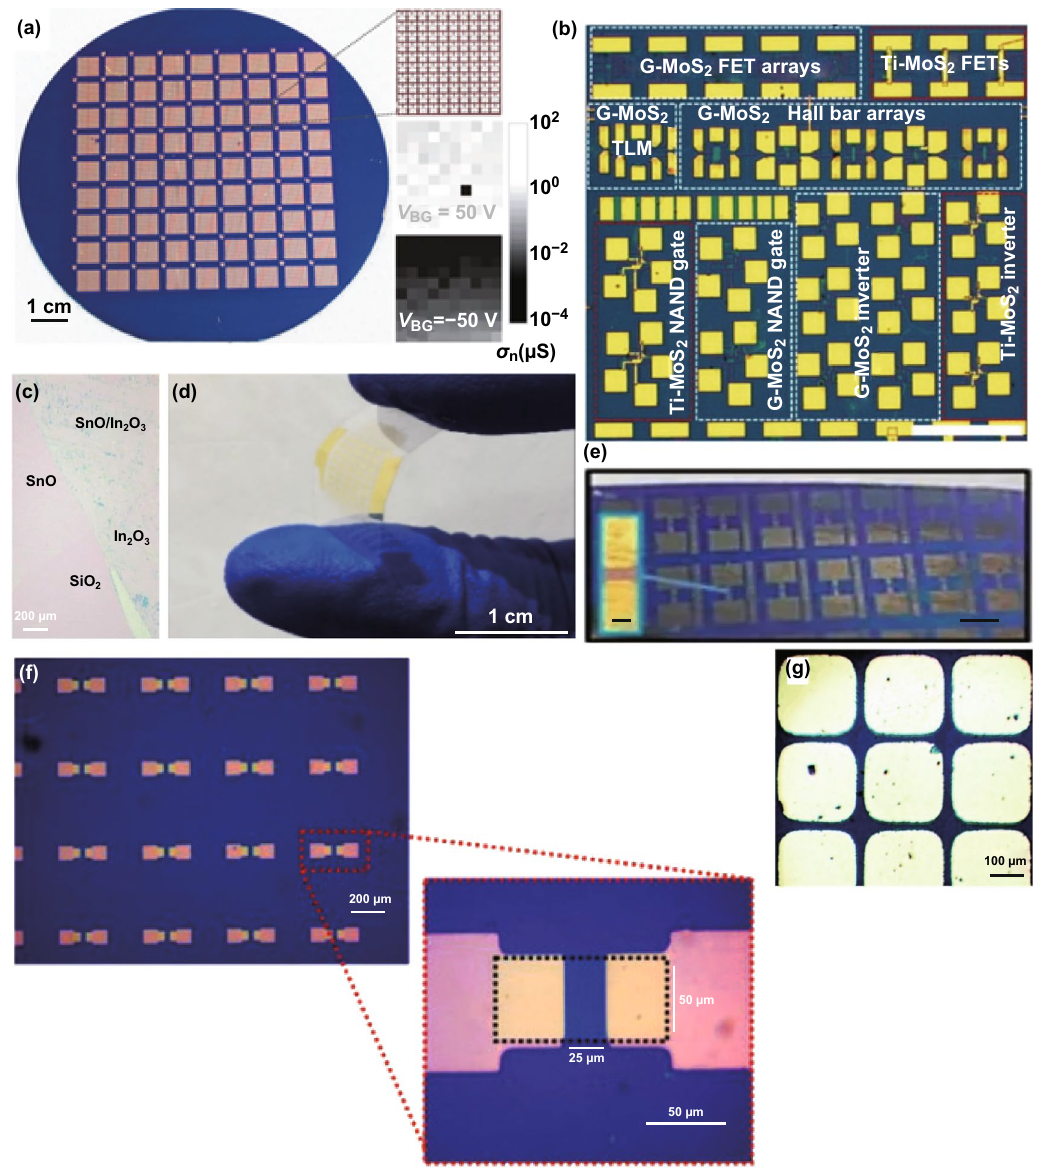
Fig. 20 2D large area enabled optoelectronics applications. a 8100 FET devices from synthesised large-area monolayer of MoS 2 . The top inset shows area with 100 FET devices. Bottom insets indicate one non-functional device found in the 100 shown devices when 50 V is applied to the gate. Adapted with permission from Ref. [178]. Copyright 2019, MDPI publishing. b Optical image of a large-area integrated chip from MoS 2 monolayers including graphene and Ti/Au electrodes. Scale bar is 500 µm. Adapted with permission from Ref. [126]. Copyright 2014,